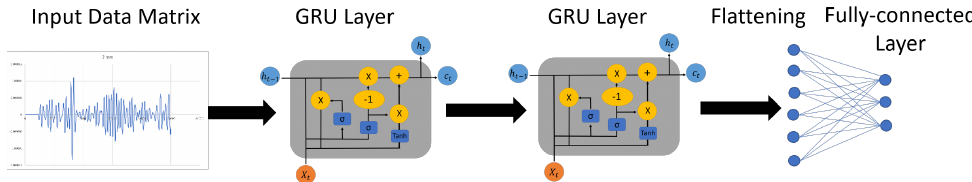
Figure 11. Graphic representation of the GRU’s configuration, chosen after the optimization process, with two layers.